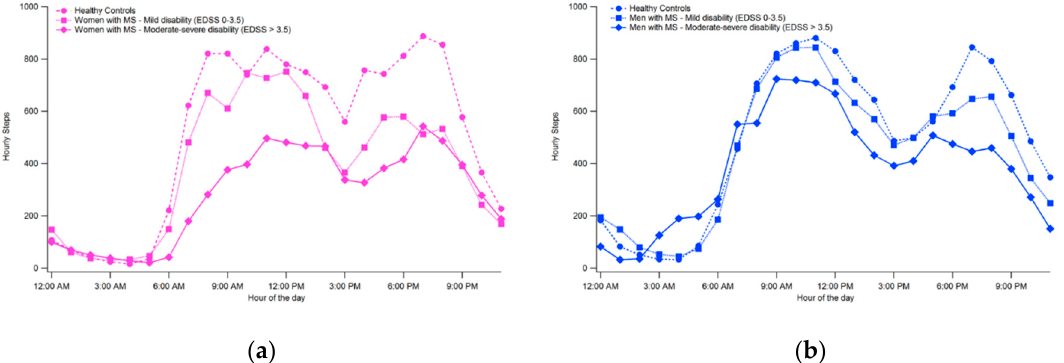
Figure 2. Comparison of hourly trends in women ( a ) and men ( b ) for step counts.